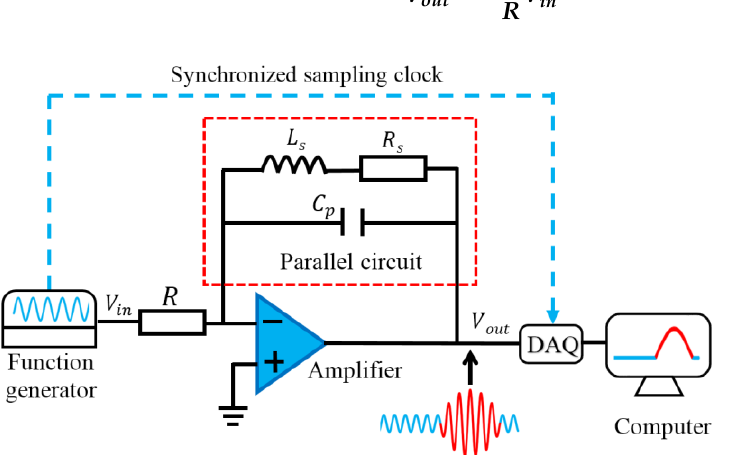
Figure 6. The schematic diagram of the experimental setup for the signal detection with the parallel LC resonance